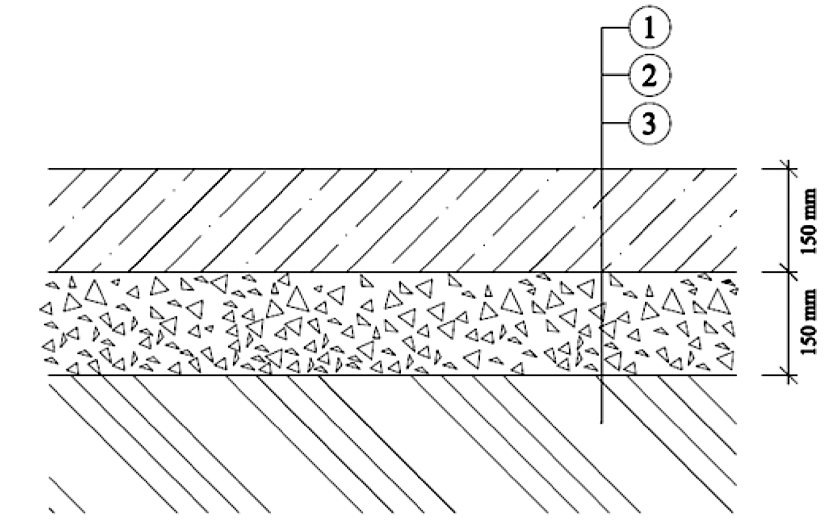
Figure 1. Subsoil composition.